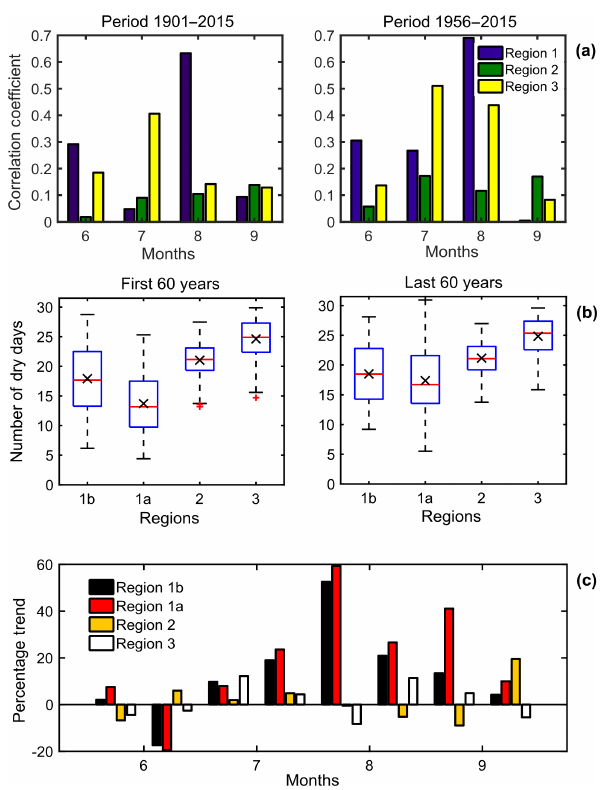
Figure 2. (a) Correlation coefficients between DI and DDF